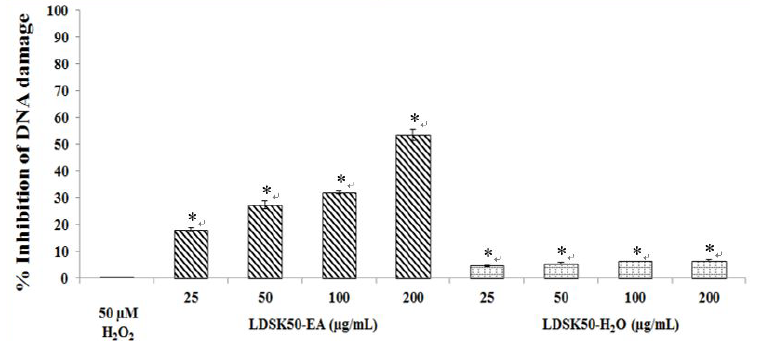
Figure 4. Inhibitory effect of LDSK50-EA (fractions of 50% ethanol extract of the L. domesticum skin followed by ethyl acetate (EA) fractionation) and LDSK50-H 2 O (the aqueous phase product when the L. domesticum skin was extracted with 50% aqueous ethanol and partitioned with EA) on H 2 O 2 -induced DNA damage in TK6 cells by comet assay. Results were expressed as means ± standard deviation (SD) ( n = 3). * Significant difference was detected from 50 µM H 2 O 2 treatment groups at p ≤ 0.05.